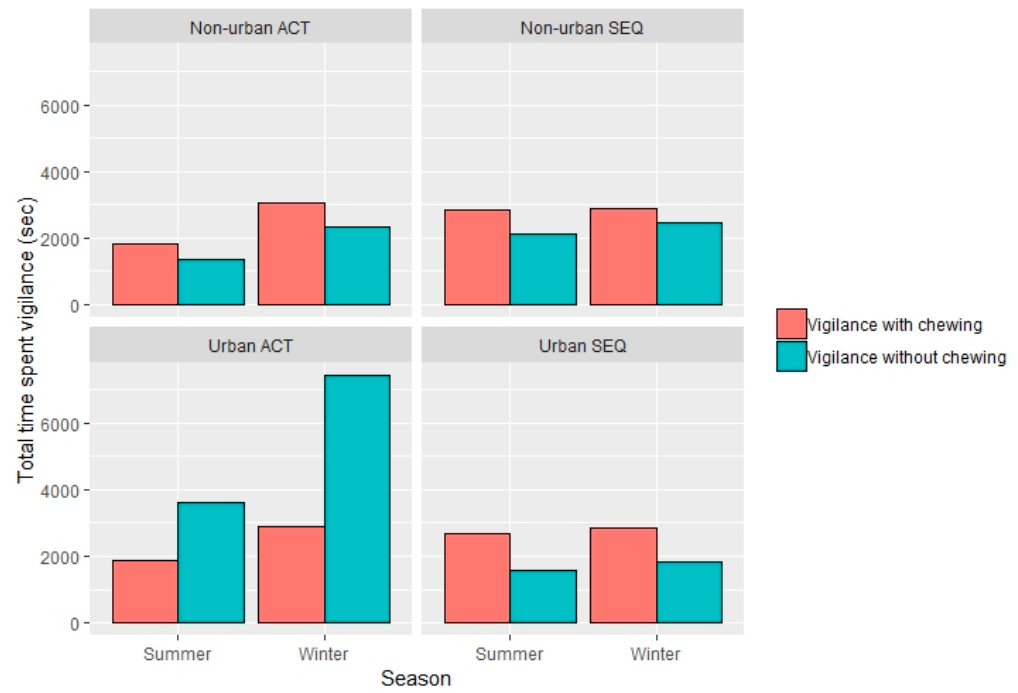
Figure 3. Total time spent displaying vigilance with or without chewing in eastern grey kangaroos found in different types of land use in south-east Queensland and the Australian Capital Territory.